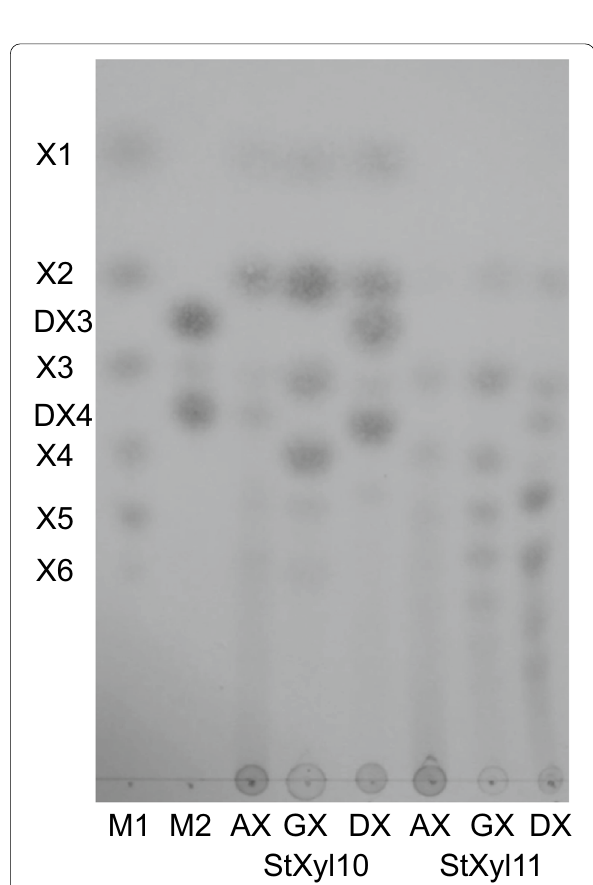
Fig. 3 TLC analyses for the hydrolysis products of xylan by StXyl10 and StXyl11. Ten milligrams per milliliter xylan (AX, DX and GX) in 10 mM sodium phosphate buffer (pH 6.5) was hydrolyzed with 1.0 μg/mL StXyl10 at 50 °C for 24 h and 1.0 μg/mL StXyl11 at 60 °C for 24 h. One microliter of each mixture was applied for TLC analysis. M1, marker of X1-X6; M2, marker of DX3 and DX4; AX, arabinoxylan; DX, dulse xylan; GX